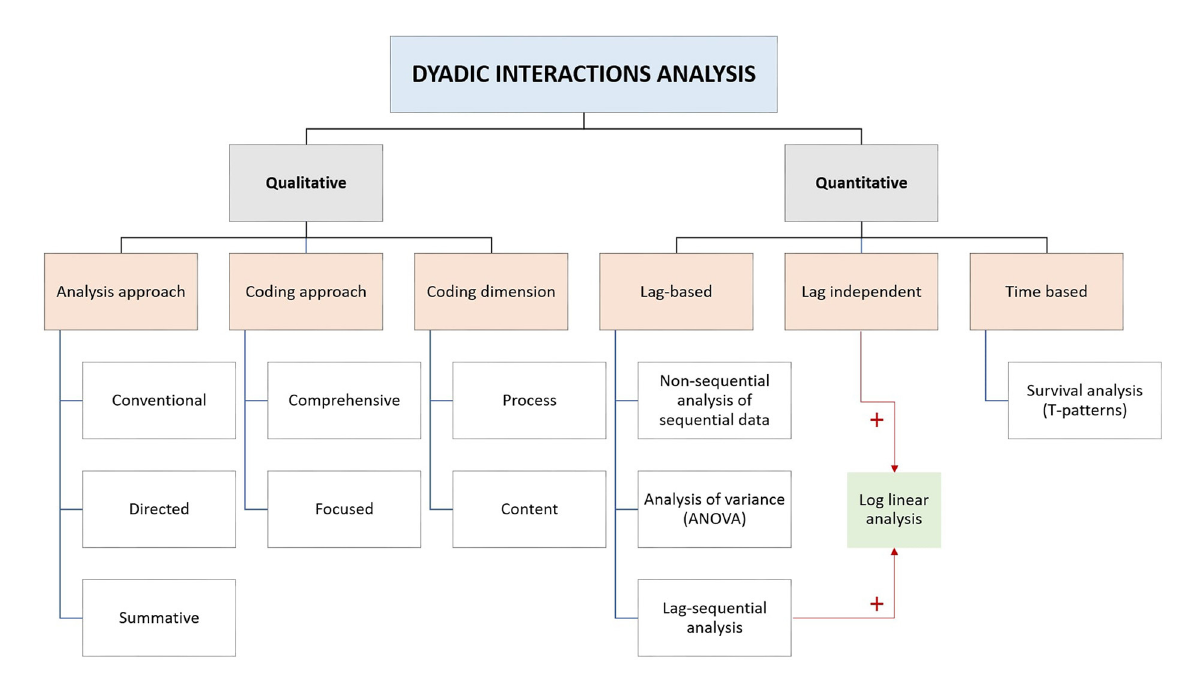
FIGURE1 Schematic diagram of our dyadic interaction analysis